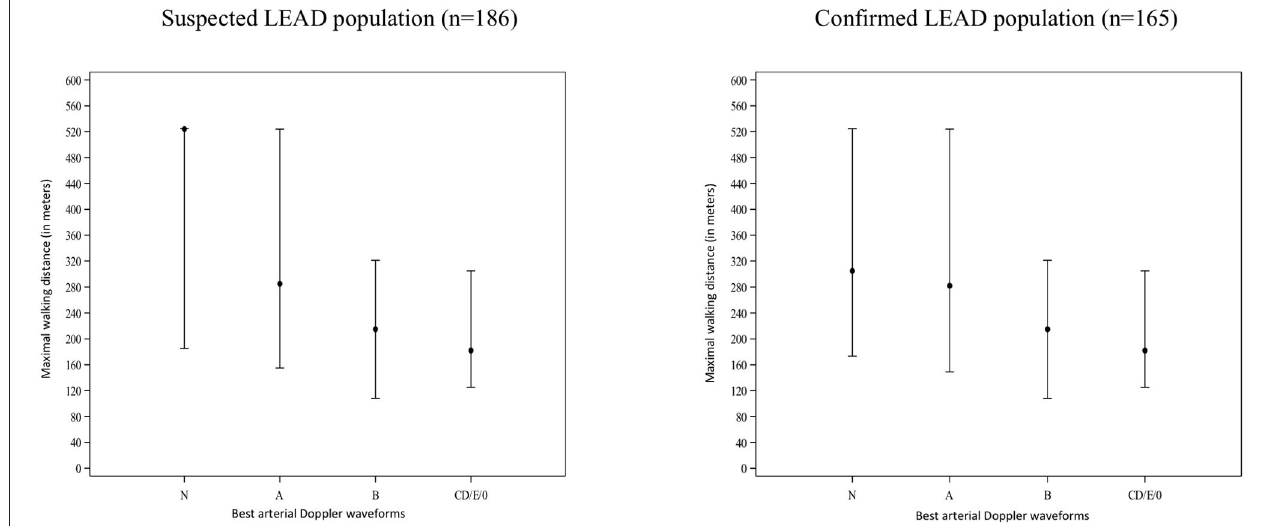
FIGURE 3 | Maximal walking distance and arterial Doppler waveforms in patients suspected of LEAD and in confirmed LEAD. Results shown as medians [Q1 First quartile-Q3 Third quartile]. Simplified Saint-Bonnet classification sorts types according to severity of arterial lesions (Saint-Bonnet N, Saint-Bonnet A, Saint-Bonnet B,